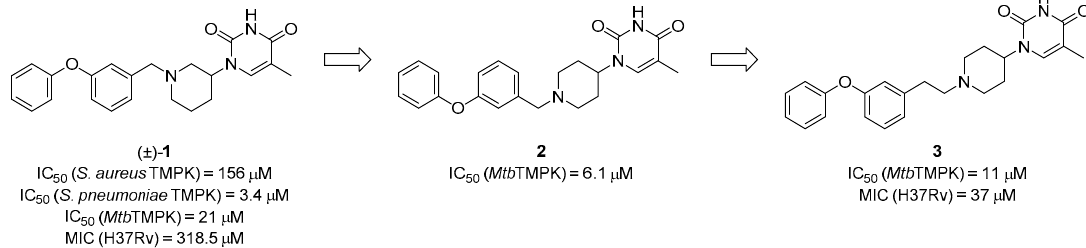
Figure 1. Structures of reported Mtb TMPK inhibitors 1 , 2 and 3 and their TMPK inhibitory potency and antitubercular activity [14,20]. Compound 3 was resynthesized and re-evaluated herein as a reference. MIC: minimum inhibitory concentration.